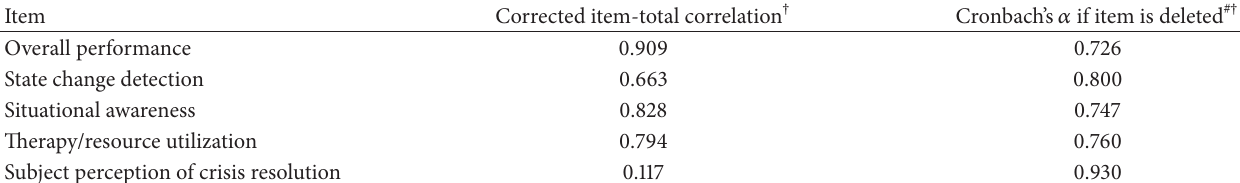
Table 1: Internal consistency of Global Rating Scale considering all emergency scenarios.